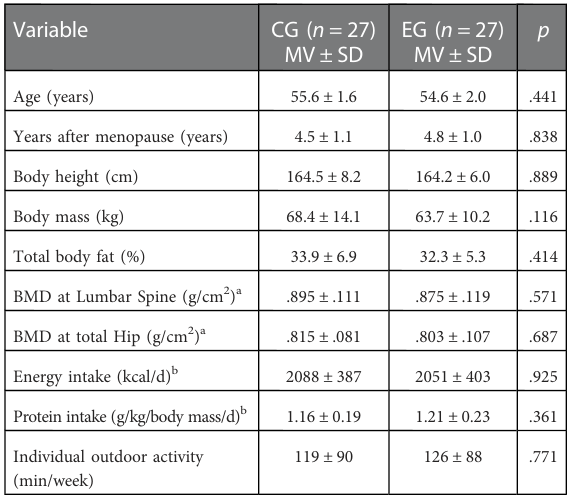
Please add “ Table 1 : 13-month Follow-up characteristics of the ACTLife-RCT study ” about here . TABLE 1 13-month follow-up characteristics of the ACTLife-study. Data based on imputation of missing values (CG: n =7, EG: n =6) by Amelia